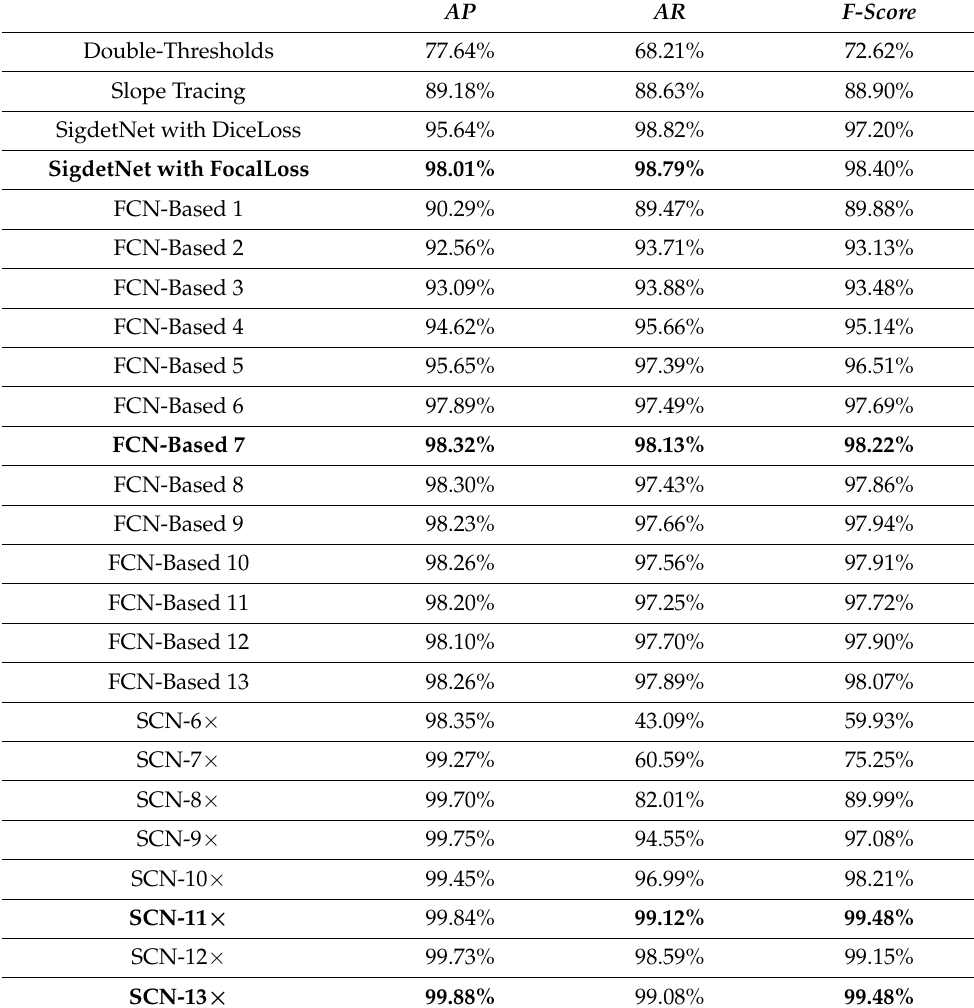
Table 2. The performance comparison between the proposed method and other methods. AP